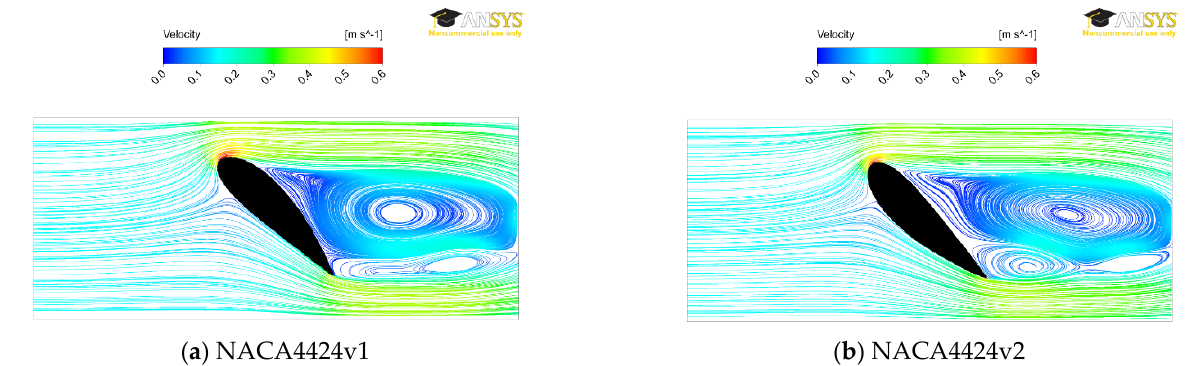
Figure 8. Stream lines during the flow around the blade in the channel. ( a ) for normal setting, ( b ) for reverse setting.